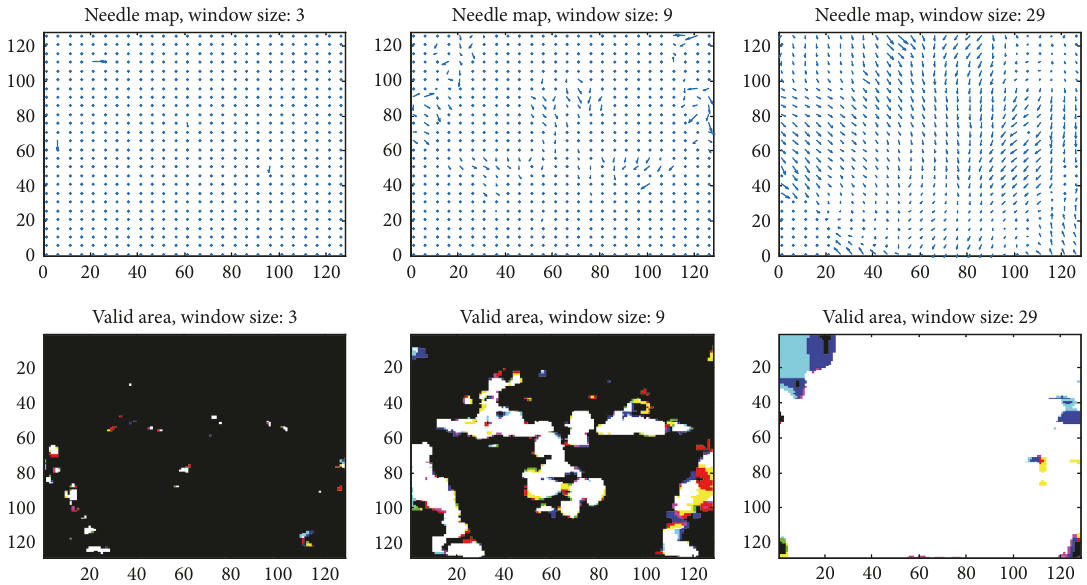
Figure 5: Feature abstracted by optical flow with window sizes 3, 9, and 29.